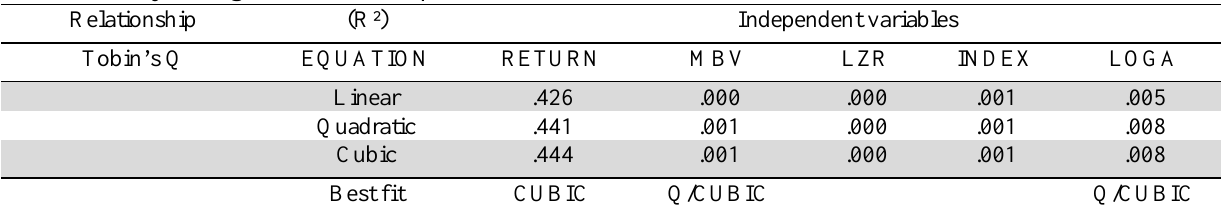
The summary of regression technique Relationship